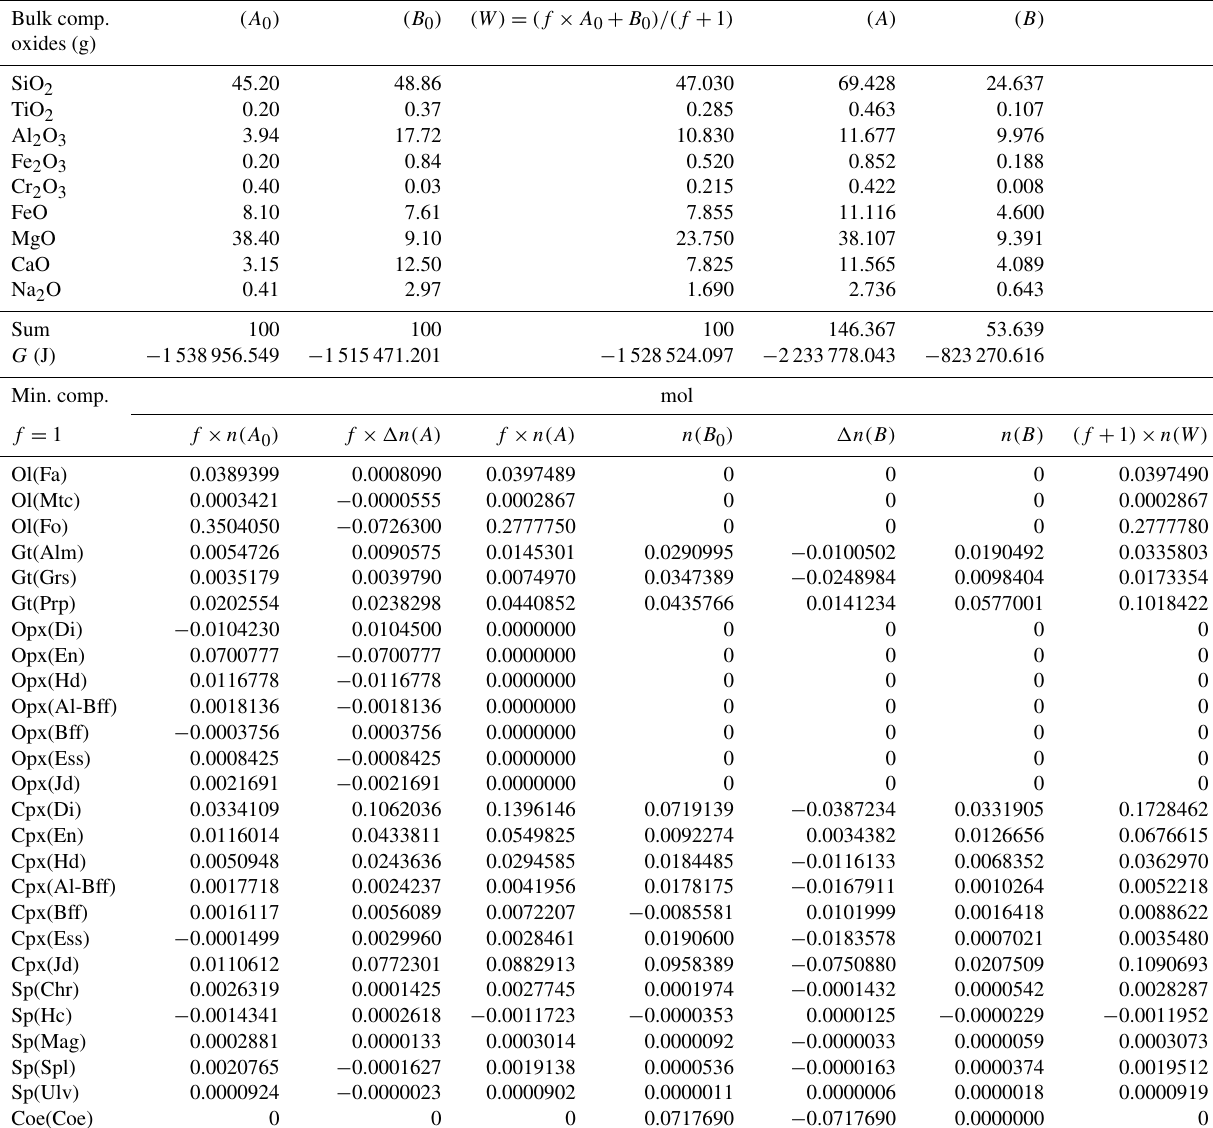
Table 3. Summary of the results of one chemical equilibration procedure. The columns ( A 0 ) and ( B 0 ) describe the initial bulk composition of the two subsystems and the Gibbs free energy G (joules) of the equilibrium assemblages separately. Following the AlphaMELTS input format, the bulk compositions are given in grams. The initial proportion of the whole system is f : 1 ( f = 1) and the whole composition is reported in column ( W ). Columns ( A ) and ( B ) in the upper portion of the table present the results of the chemical equilibration in terms of oxides. Note that the sum of the oxides is not 100, which indicates a mass transfer between the two subsystems. The columns in the lower part of the table show the composition of the mineral components at equilibrium before the two subsystems are put together ( f × n(A 0 ) and n(B 0 ) and after equilibration of the whole system ( f × n(A) and n(B) ). The change in moles ( f × (cid:49)n(A) , (cid:49)n(B) is also reported. The last column is the composition of the whole system ( W ) after